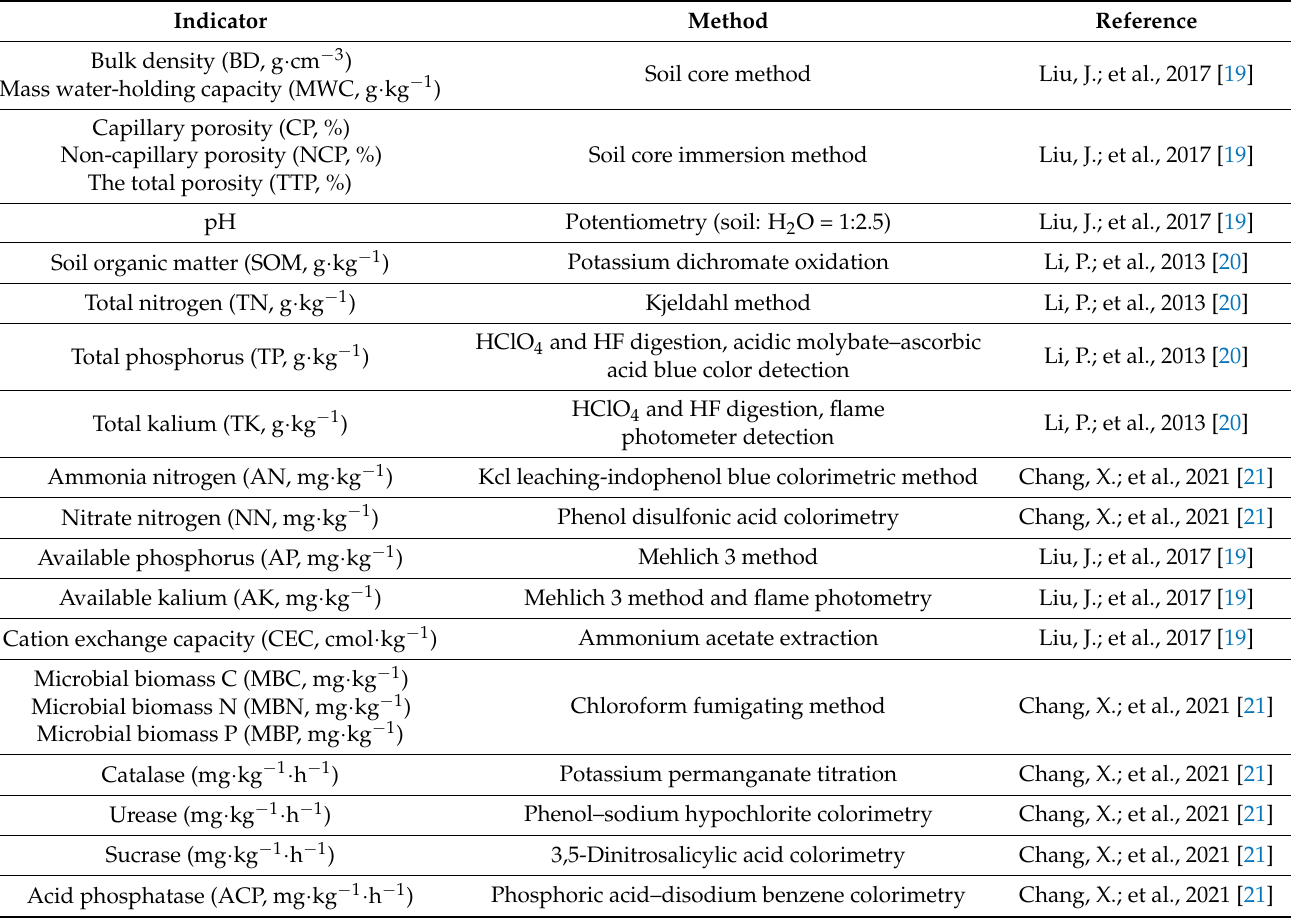
Table 2. Determination methods of physical, chemical, and biological indicators of